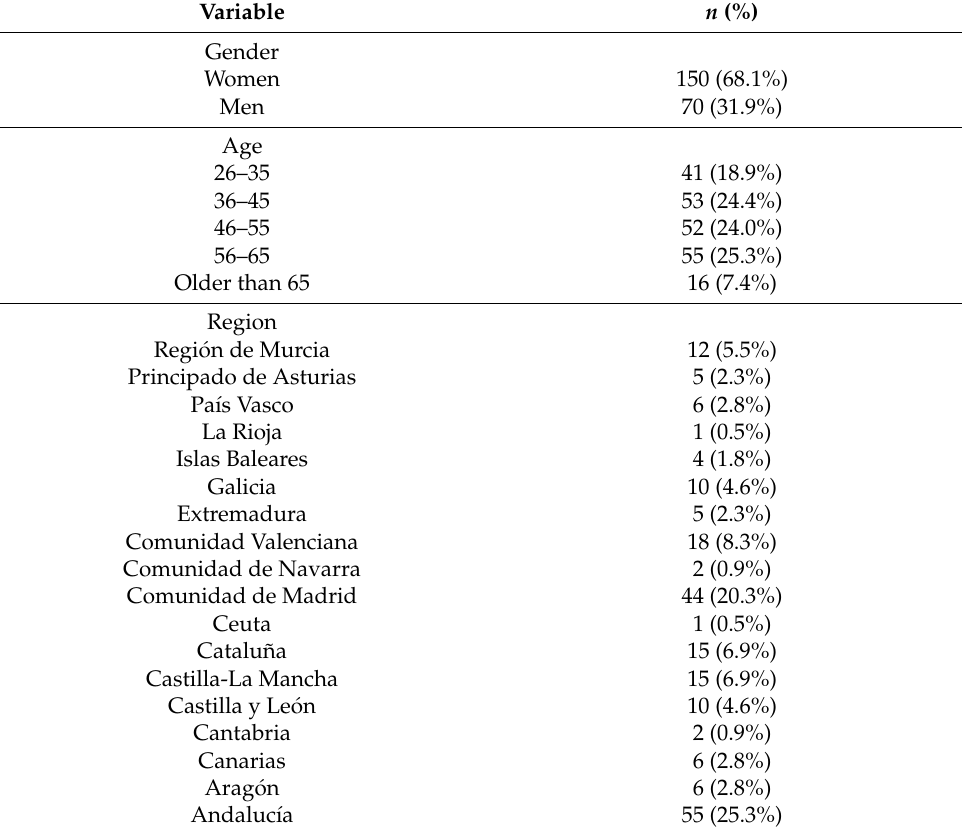
Table 1. Sociodemographic